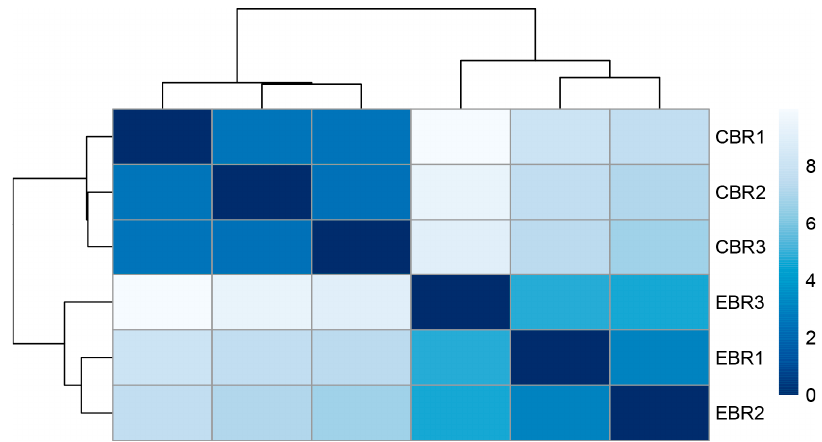
Figure 3. Heatmap of the clustering of samples from different treatment groups.